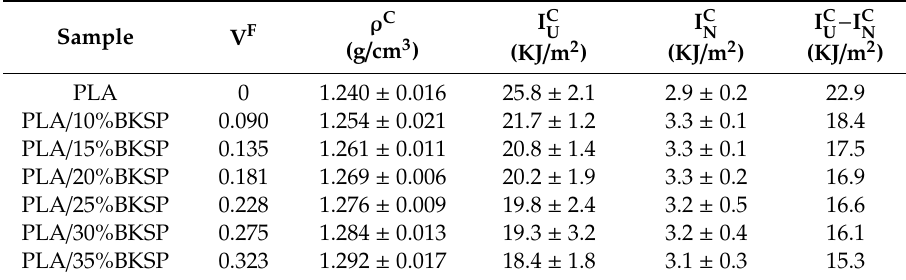
Table 3. Impact resilience of Charpy un-notched and notched poly (lactic acid) (PLA) / BKSP composites against reinforcement